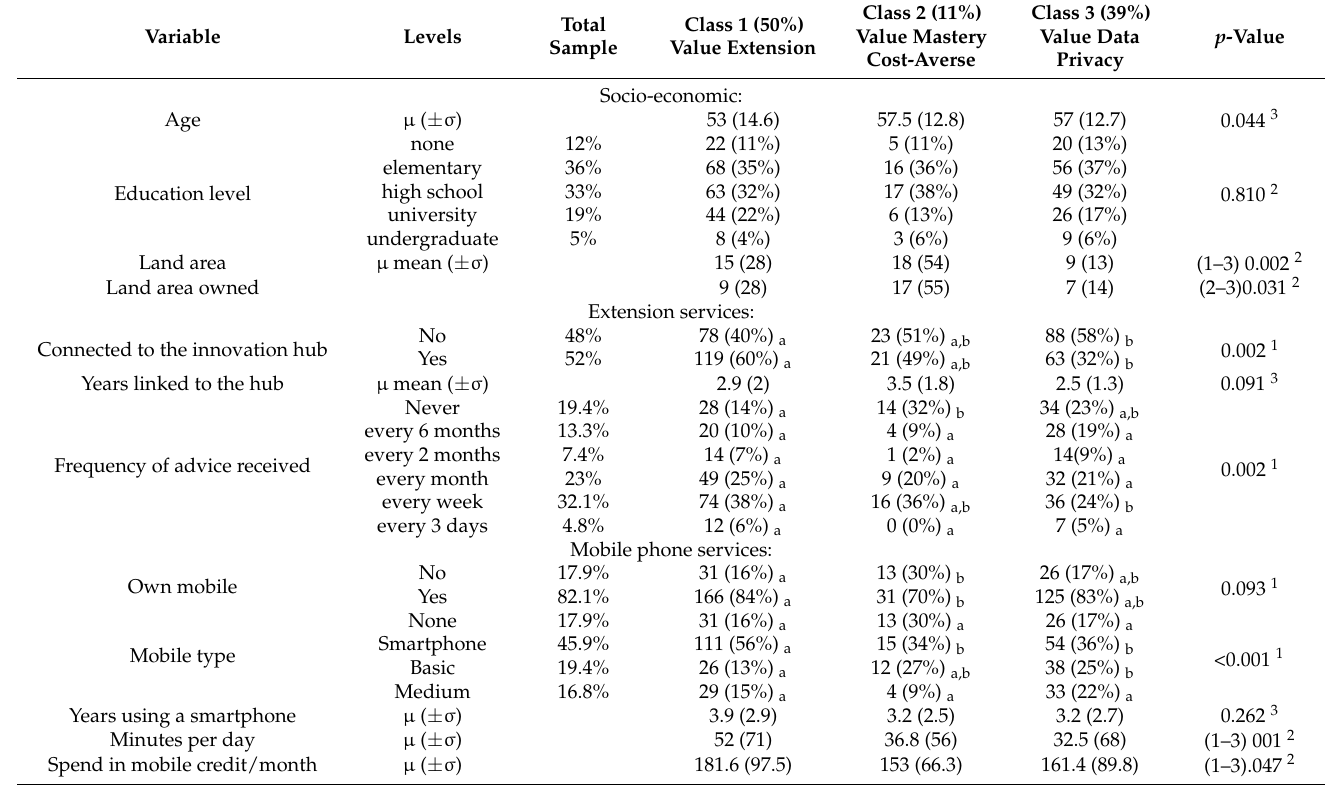
Table 5. Profiling farmers’ latent